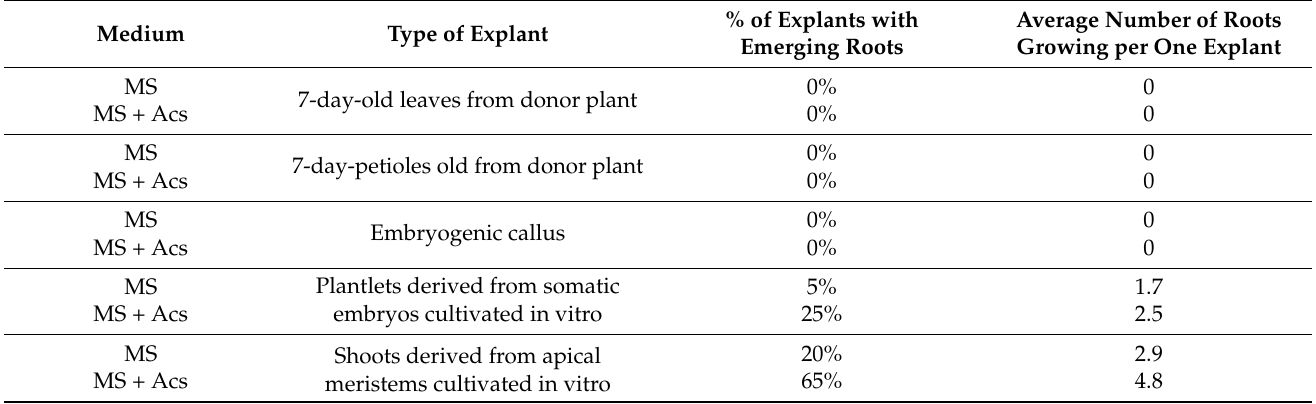
Table 1. Efficiency of hairy root formation on various explants infected with Agrobacterium rhizogenes ATCC 15834 strain and incubated on MS medium with or without acetosyringone